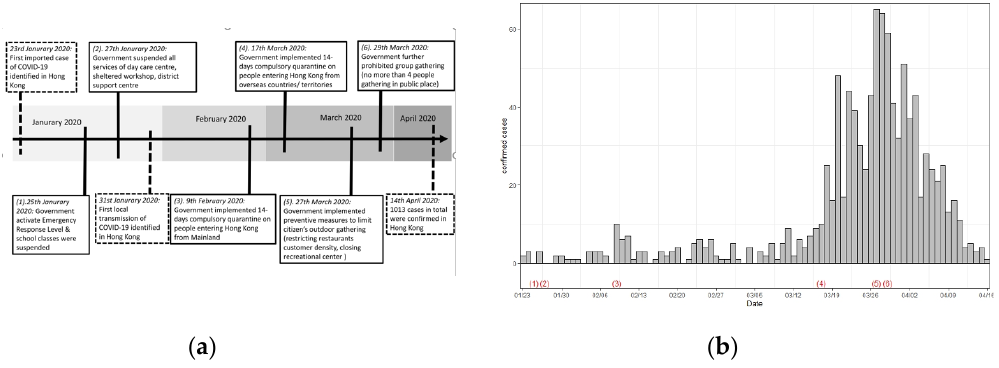
Figure 1. ( a ) Timeline of the COVID-19 outbreak in Hong Kong and the preventive measures implemented by the Hong Kong government. ( b ) The confirmed cases in Hong Kong from 23 January 2020 to 16 April 2020. Note: (1) to (6) in Figure 1b correspond to (1) to (6) in Figure